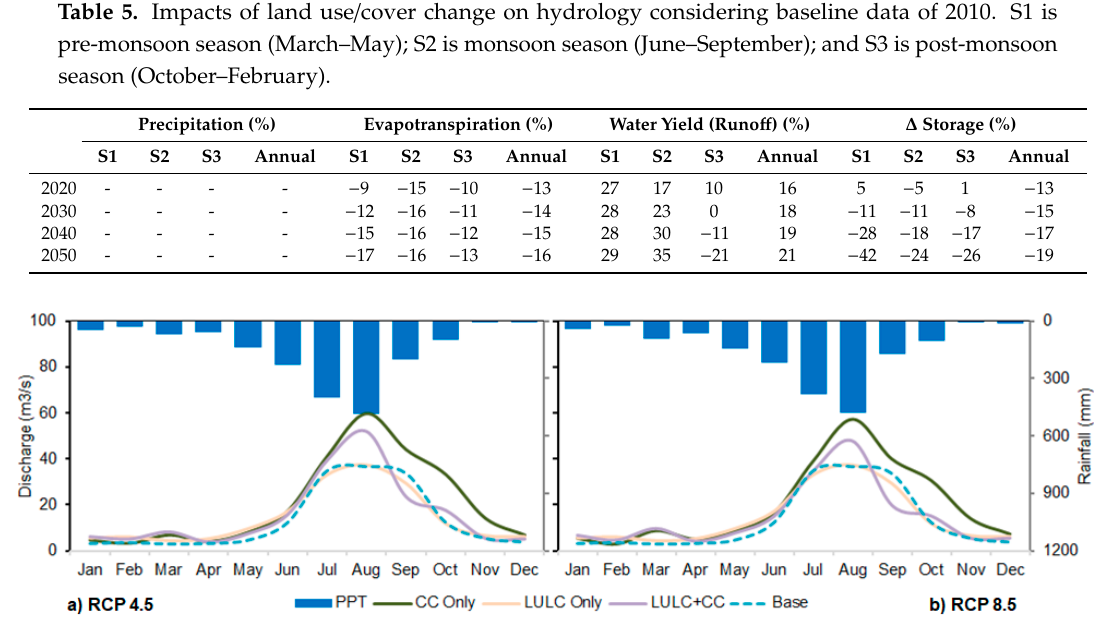
Figure 5. Projected average monthly river discharge at Khokana station under various scenarios.